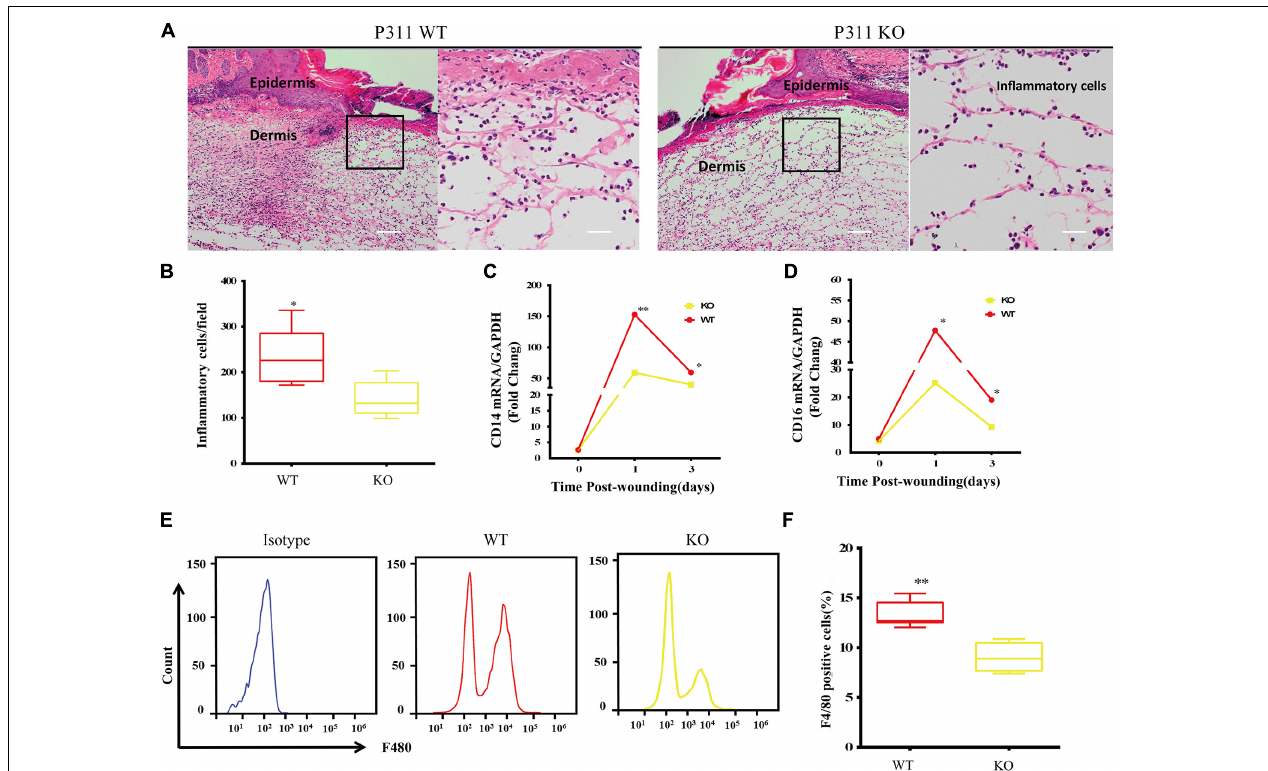
FIGURE 3 | Effect of P311 on the inflammatory response during wound healing. (A) Representative histological analysis of a skin wound by H&E staining on the 3rd day. The area marked by the black box in the left column is enlarged to display the mononuclear inflammatory cells in the right column. Scar bar = 200 µ m, 50 µ m. (B) Quantitation of mononuclear inflammatory cells in the granulation tissues from H&E-stained wound sections on the 3rd day ( n = 3 animals per genotype). CD14 (C) and CD16 (D) mRNA expression in wounds on days 0, 1, and 3 after injury ( n = 3 animals per time point and genotype). GAPDH and β -actin are the housekeeping genes used to perform the qPCR analysis. (E) Representative flow cytometry of F4/80. (F) Quantitation data of flow cytometry ( n = 3 animals per genotype). Data represented mean ± SD, Student T -test, ∗ P < 0.05, ∗∗ P < 0.01, P311 KO vs. WT.